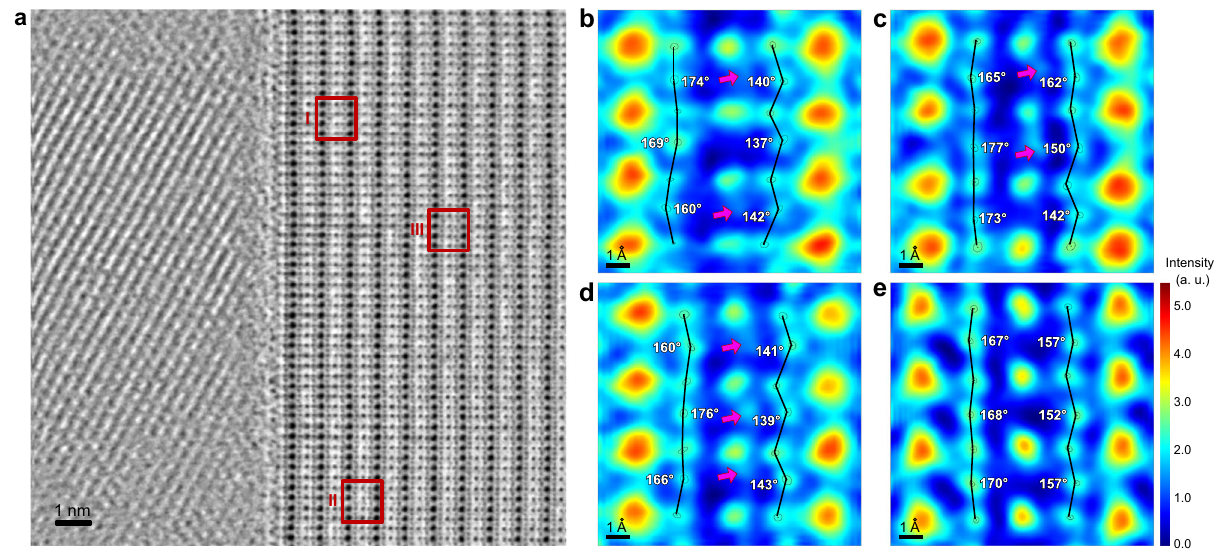
Fig. 3 | Atomic con fi guration in the SCL. a ABF-STEM image of the vicinity of a grain-boundary core. The grain at the right was observed along <110> p . b – e EnlargedABF-STEMimagesofregionsI( b ),II( c ),andIII( d )in a ,alongwithone takenfromthebulk( e ).The magni fi cationsof theseenlargedimagesare thesame.